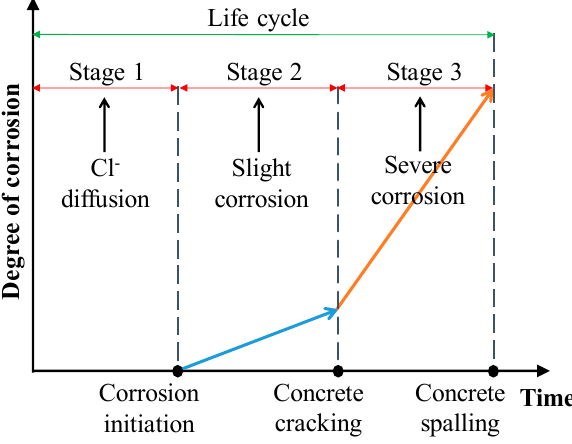
Figure 4. Deterioration process of chloride-induced RC structure corrosion.